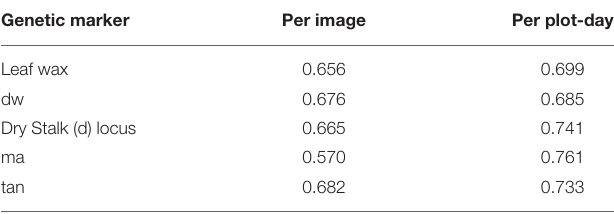
TABLE 4 | Comparison with per plot-day